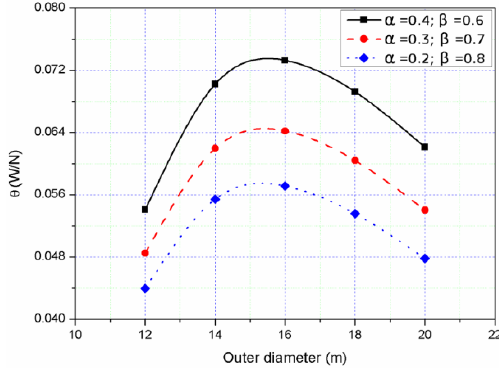
Figure 3. θ values for different outer diameters of the WEC.